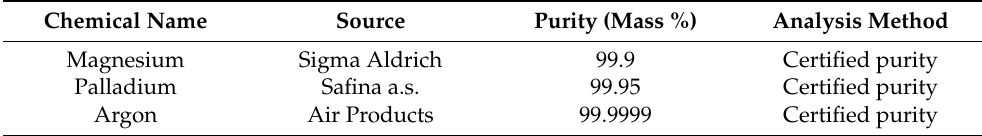
Table 1. Specifications of the applied materials.